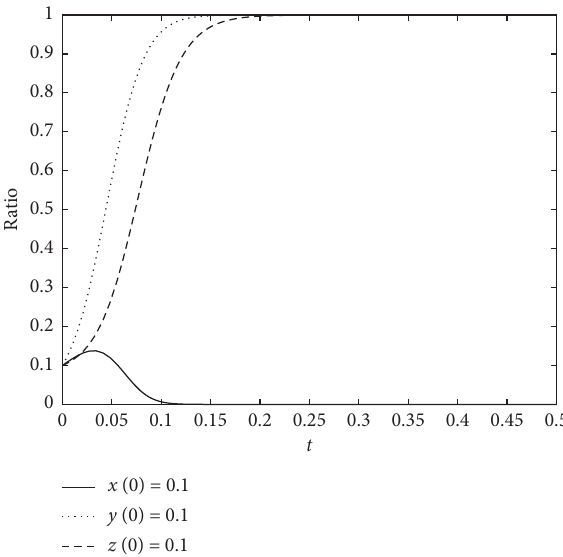
Figure 4: Different initial proportions of influence among gamers regarding the evolution of government.